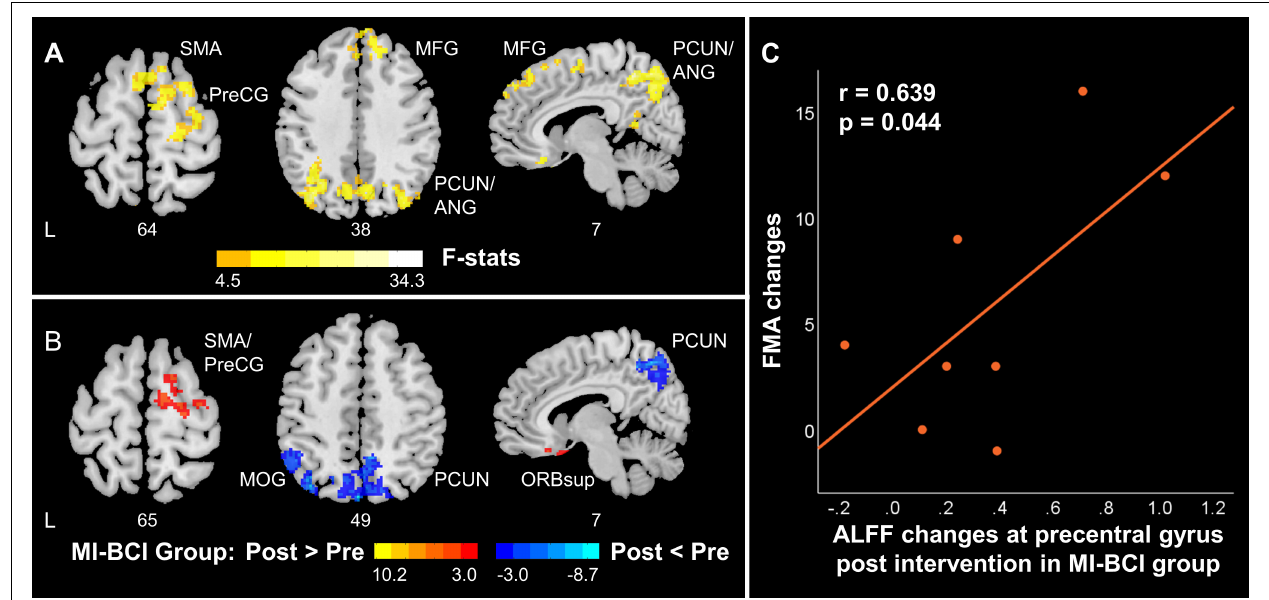
FIGURE 3 | ALFF changes in contralesional SMN and posterior DMN in stroke patients along with motor function recovery. (A) The interaction between time and group. The MI-BCI group and MI-BCI + tDCS group showed divergent intervention effects at contralesional SMN and DMN. (B) Intervention effect in MI-BCI group. MI-BCI group showed increased ALFF at contralesional SMN and decreased ALFF at DMN. No such effect was observed in the MI-BCI + tDCS group. (C) Correlation between FMA changes and ALFF changes in the MI-BCI group. A positive correlation was observed between FMA changes and ALFF changes post intervention in the MI-BCI group at the precentral gyrus. No such correlation was observed in the MI-BCI + tDCS group. L, Ipsilesional Hemisphere; DMN, Default Mode Network; SMN, Somatomotor Network: HC, Healthy Control; Precg, Precentral Gyrus; SMA, Supplementary Motor Area; PCUN, Precuneus; PCG, Posterior Cingulate Gyrus; MFG, Middle Frontal Gyrus; ANG, Angular Gyrus; INS, Insula; MTG, Middle Temporal Gyrus.